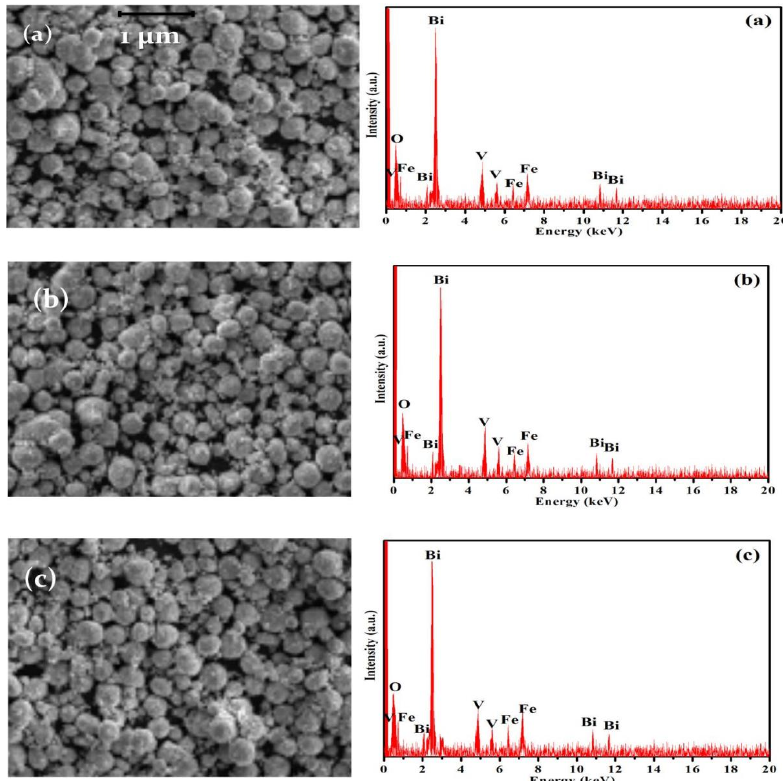
Figure 5. SEM micrographs ( left ) and EDS profiles ( right ) of BiFeVOx.y for ( a ) y = 0.03, ( b ) y = 0.07, and ( c ) y = 0.15.